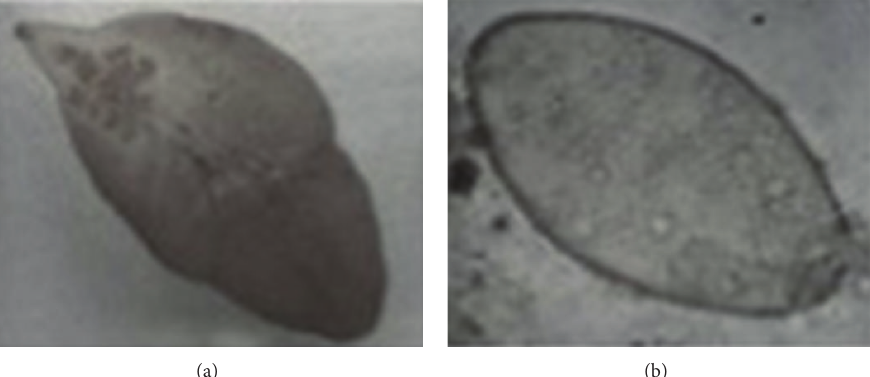
Figure 1: (a) The flat, brownish leaf-shaped adult specimen (2.5 × 1cm) gathered from the patient; (b) operculated egg of Fasciola hepatica (140 × 80 𝜇 m) evidenced in stool samples by microscopy.